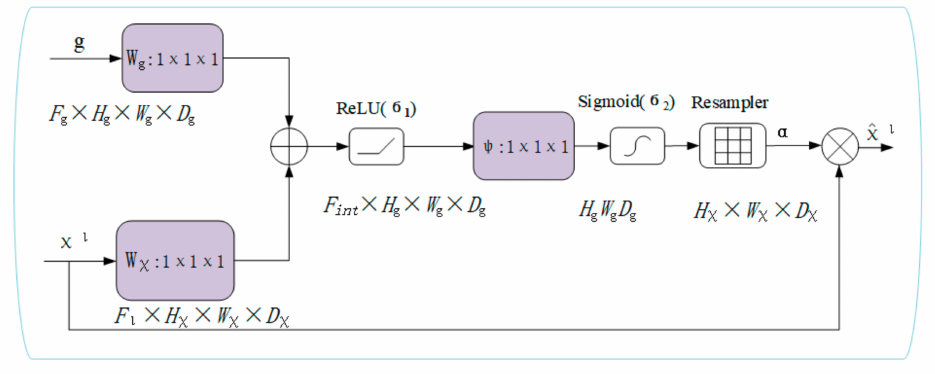
Figure 3. The proposed AG Attention